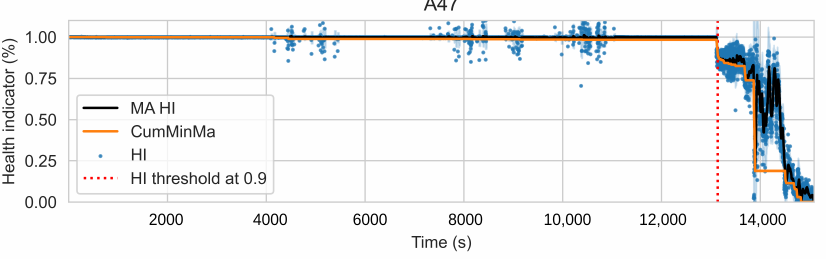
Figure 16. Health index predictions for bearing A47. Intervals as the +/ − 1 running standard deviation.